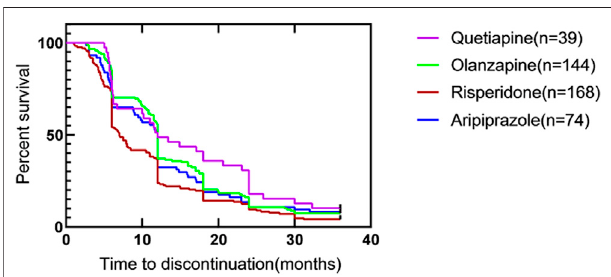
FIGURE 3 | Time to all-cause discontinuation for four kinds of atypical antipsychotics with monotherapy, Kaplan – Meier survival curve #. #. Survival curves are estimated on the basis of the observed raw data using the non- parametric Kaplan – Meier approach.